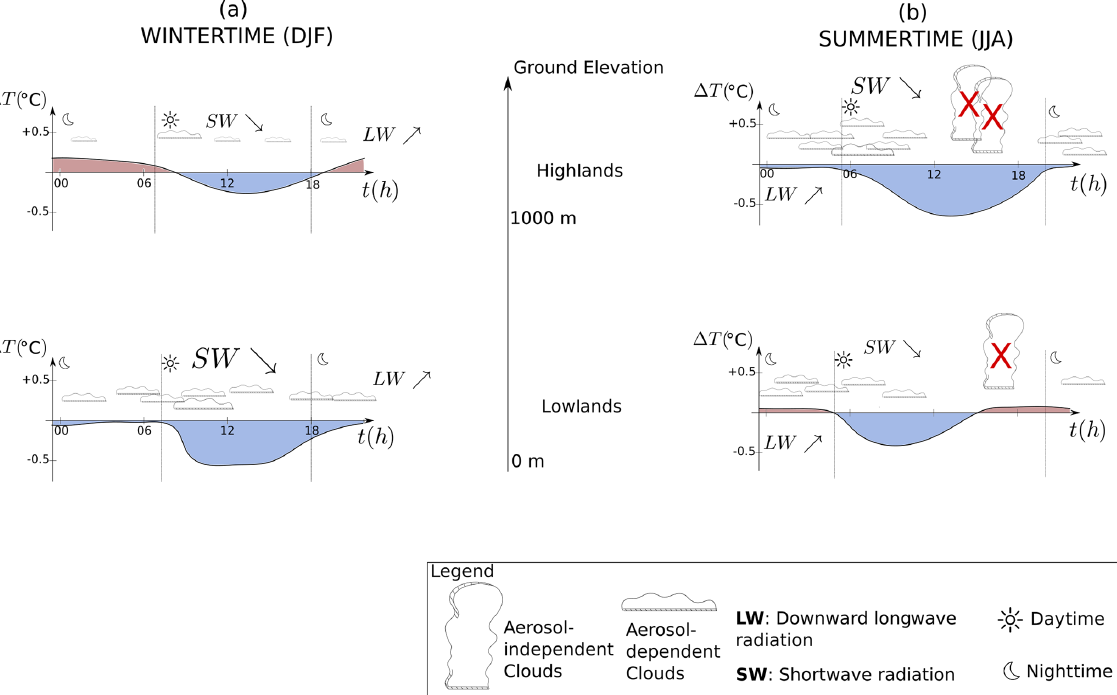
Figure 6. Concluding sketch representing the daily cycle of the anomaly features in a POLLUTED environment in lowlands and highlands for (a) wintertime (DJF) and (b) summertime (JJA). The arrows represent the change with respect to the PRISTINE environment: upward arrows indicate an increase, while downward arrows indicate a decrease. The colors blue and red represent negative and positive anomaly of temperature, respectively. Red crosses represent the suppression of the objects to which they